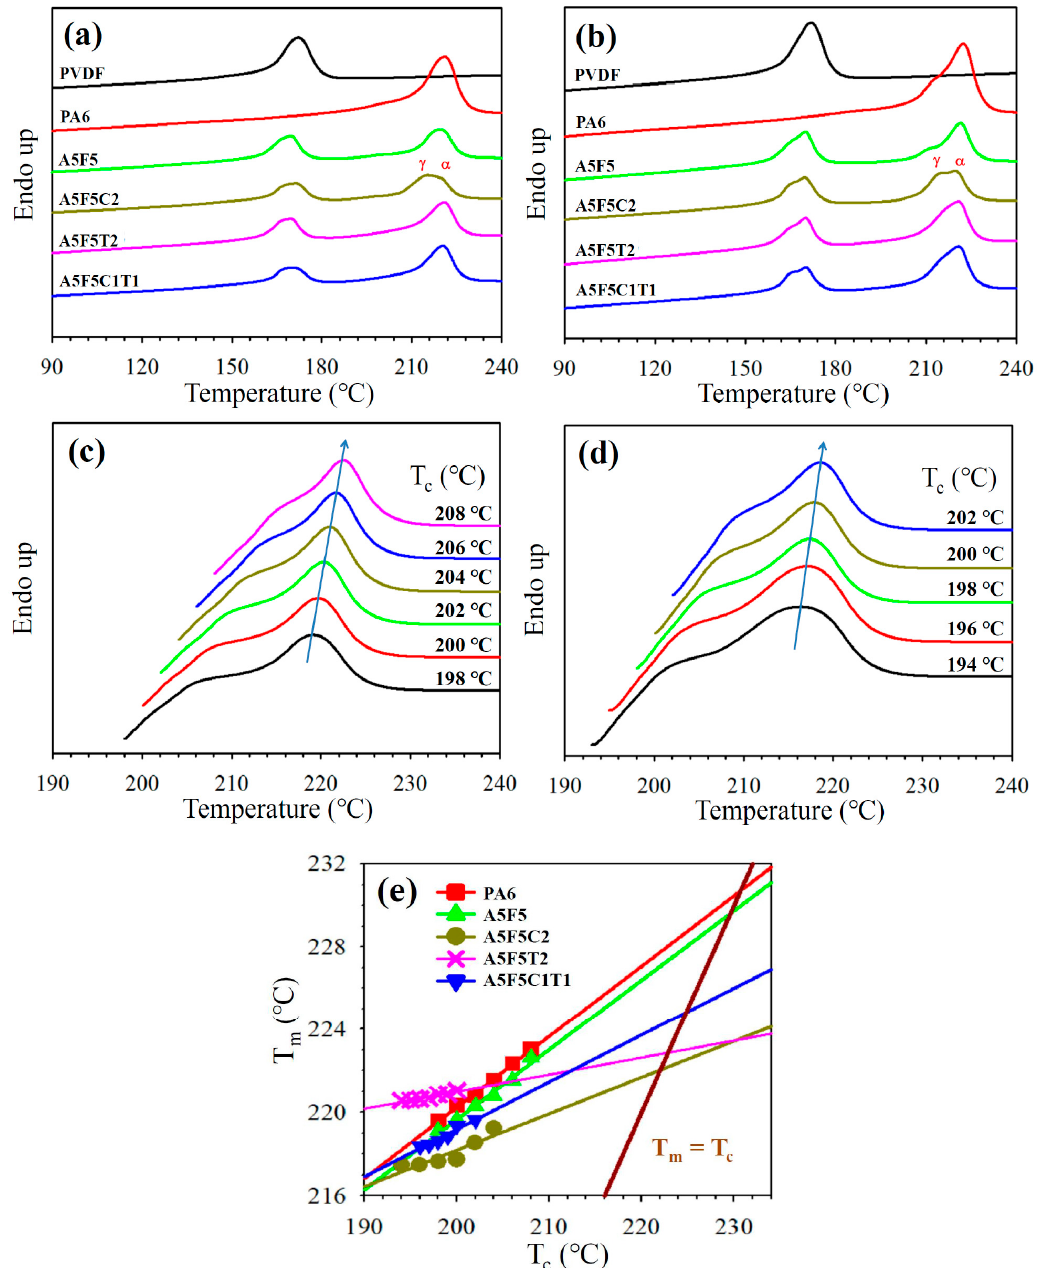
Figure 5. DSC heating curves of different samples: ( a ) 5 °C/min pre-cooled and ( b ) 40 °C/min pre-cooled; DSC melting curves of PA6 isothermally crystallized at indicated T c in: ( c ) A5F5 and ( d ) A5F5C2; ( e ) Hoffman-Weeks plots for determining T mo of PA6 in different samples.